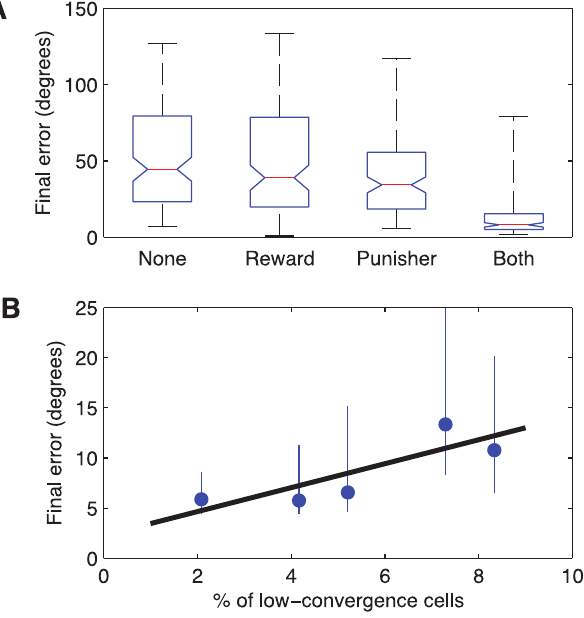
Figure 3. Performance across learning conditions and random wiring seeds. A. End-of-trial errors under different learning conditions: no learning, reward-only, punisher-only, reward-and-punisher; N ~ 125 for each: 5 target angles (0 u , 35 u , 75 u , 105 u , 135 u ) 6 5 random wirings 6 5 random babble noise inputs. B. Learning performance as a function of the percentage of EM cells that have low-convergence, defined as having fewer than five afferent inputs. The final error appears to be strongly correlated with the proportion of low-convergence cells ( N ~ 5 ; Pearson’s r ~ 0 : 83 , p ~ 0 : 08 ).